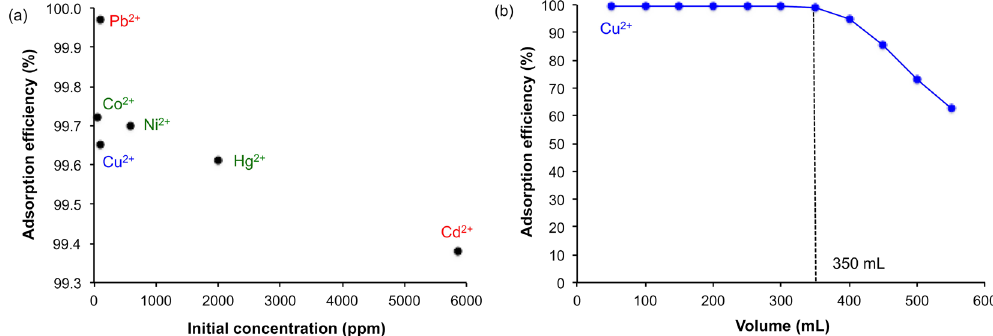
Figure 3. Uptake efficiency of the quartz wool supported-CNTs. Plots of ( a ) SENT adsorption efficiency of different metal ions as a function of initial concentration of 50 mL sample through 0.5 g SENT, and ( b ) change in adsorption efficiency as a function of solution volume for Cu 2 + (100 ppm) showing the saturation point as defined by the volume above which the adsorption efficiency decreases.